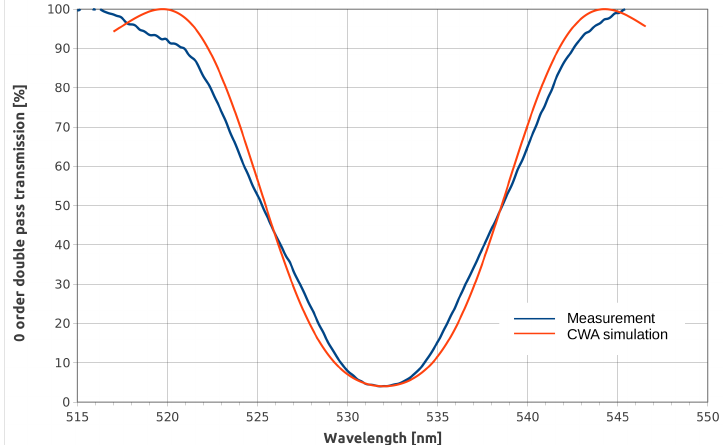
Figure 2. Double-pass transmission spectrum (zero-order) of the reflection hologram interpolated by coupled wave analysis.